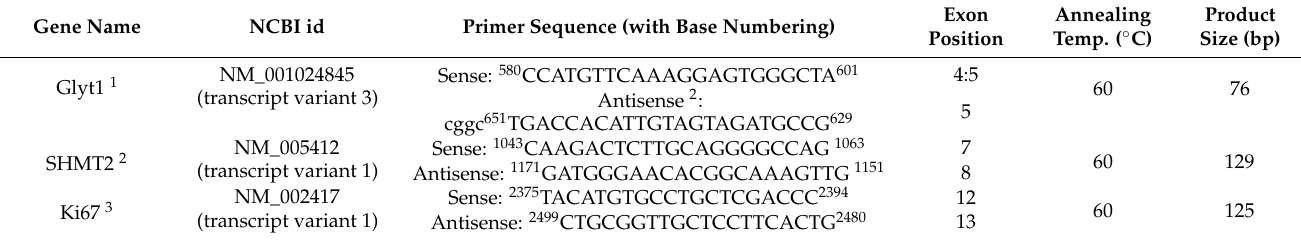
Table 1. Primers utilised in end-point PCRs and qPCRs. Description includes gene name, NCBI identification number, sequence, exon position, annealing temperature, and product size. Numbers in superscript at the start and end of each primer sequence indicate the base location in the named